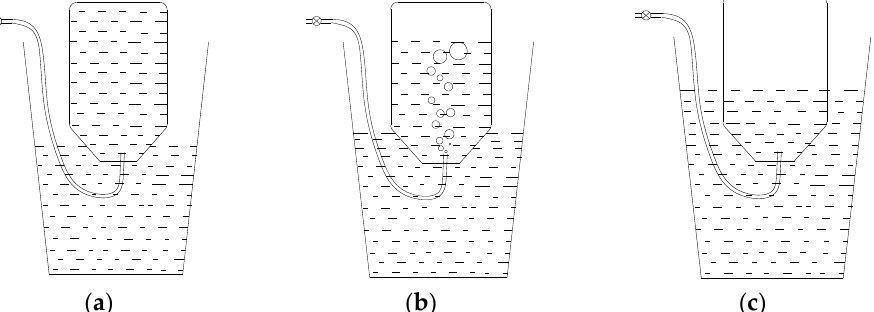
Figure 4. Schematic of noncondensable gas content measuring steps: ( a ) turn a bottle upside down filled with water; ( b ) open the valve let geothermal fluid flow inside the bottle; ( c ) move the bottle to make the liquid surface inside and outside the bottle is at the same level.